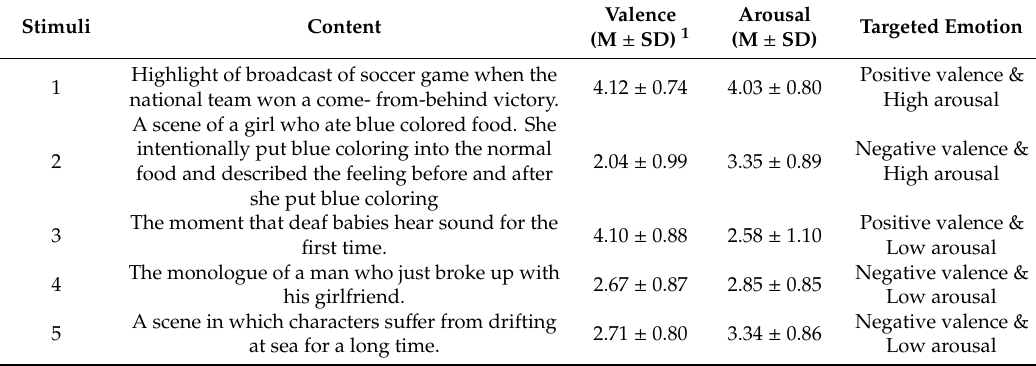
Table 1. Content of pre-test stimuli. Mean scores of each dimension also presented. Stimulus 5 was not included in the main